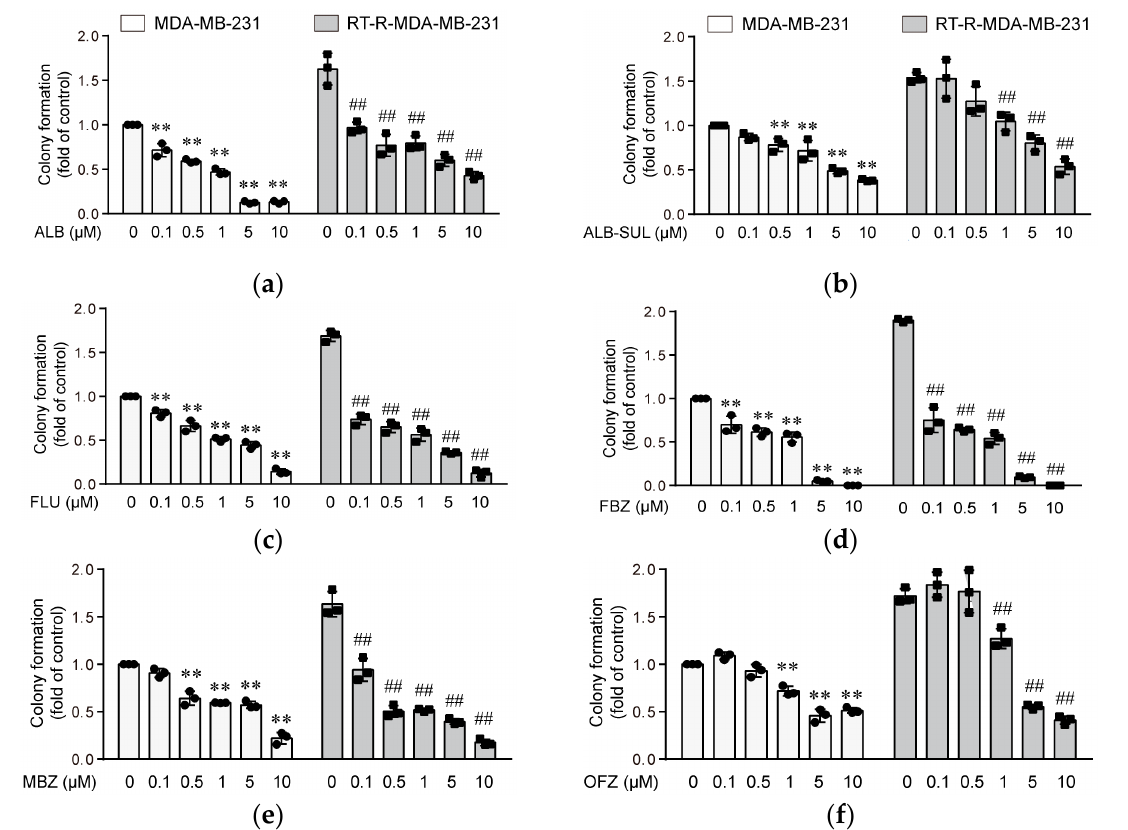
Figure 3. Benzimidazole derivatives (( a – f ): ALB, ALB-SUL, FLU, FBZ, MBZ, and OFZ) dose-dependently reduce colony-forming ability of MDA-MB-231 and RT-R-MDA-MB-231 cells. MDA-MB-231 and RT-MDA-MB-231 cells were seeded in 6-well plates (1000 cells/well) and then treated with six benzimidazole derivatives at the indicated concentrations (0.1, 0.5, 1, 5, 10 μ M). After 24 h, the culture medium was replaced with fresh medium every 2–3 days. After 10 days, the cells were fixed, stained using crystal violet, and counted. The values are expressed as the means ± SD from three independent determinations. ** p < 0.01 compared with the control of MDA-MB-231 cells; ## p < 0.01 compared with control of RT-R-MDA-MB-231 cells.